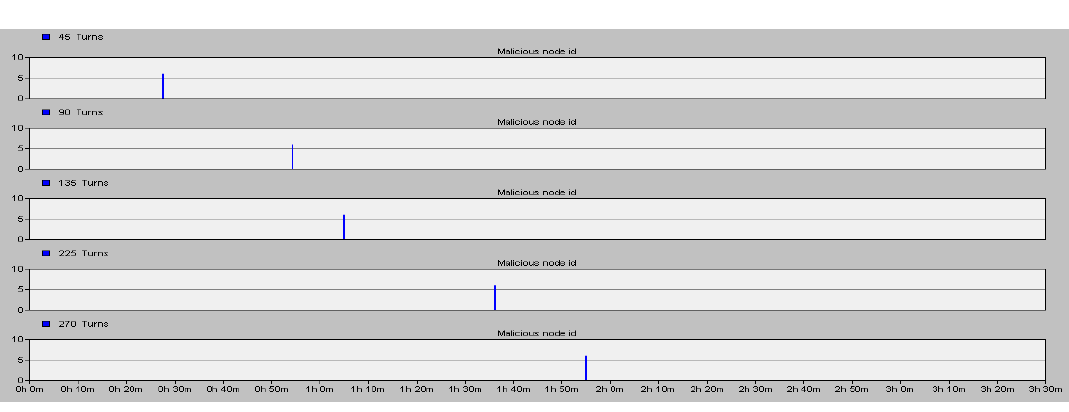
Figure 8. Detection of node 6 captured in different time.